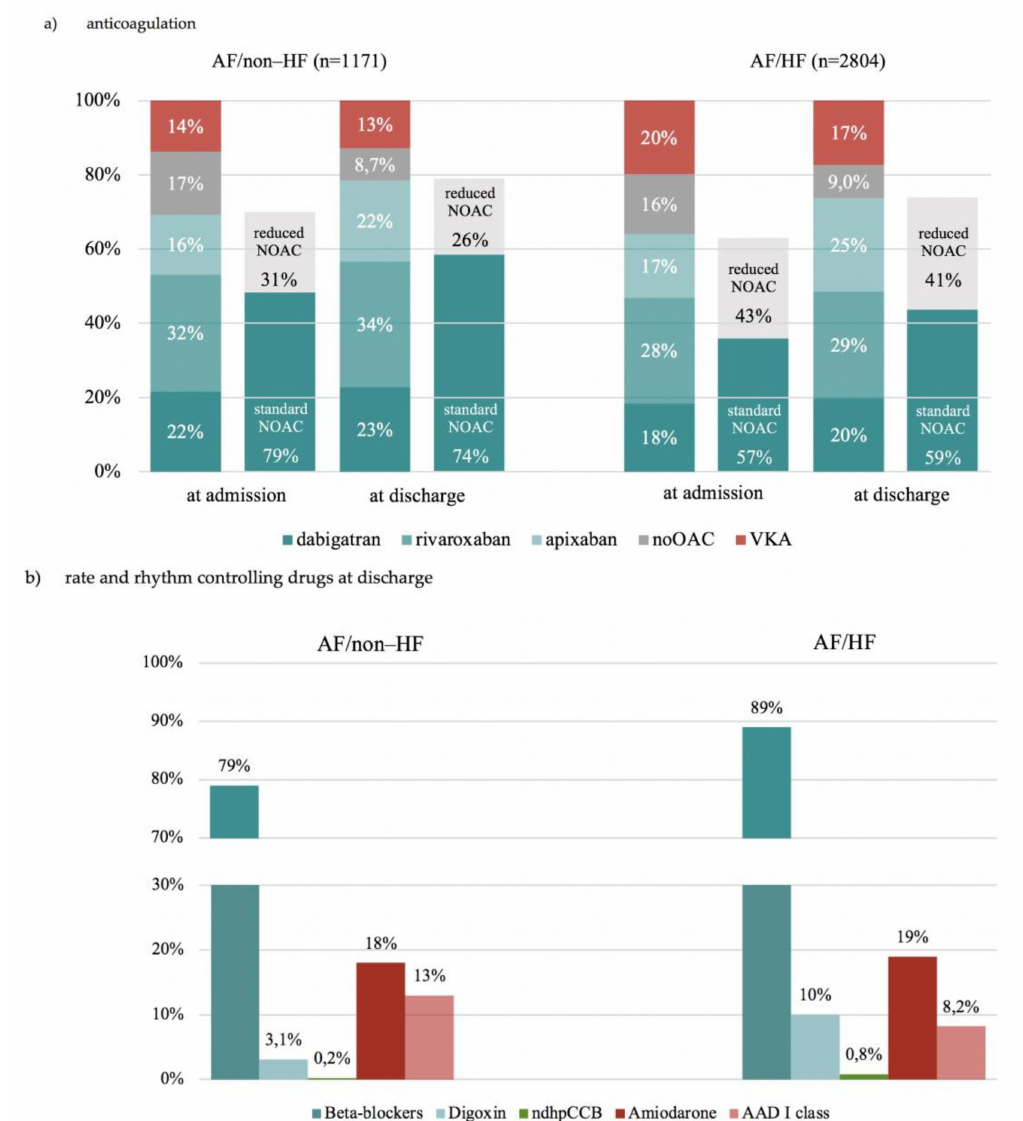
Figure 2. Pharmacotherapy of hospitalized atrial fibrillation patients depending on presence or absence of heart failure and its subtypes. ( a ) Differences between AF/non–HF vs. AF/HF group were statistically significant for all treatment subgroups ( p < 0.05), except no OAC at baseline ( p = 0.64), apixaban treatment at baseline ( p = 0.29), and no OAC ( p = 1.00) at discharge. Differences between AF/non–HF vs. AF/HF group regarding reduced and standard NOAC doses were statistically significant ( p < 0.05). ( b ) Dronedarone was not prescribed in any of the groups. Differences in pharmacotherapy between AF/nonHF vs. AF/HF group were statistically significant ( p < 0.05), except amiodarone treatment ( p = 0.53). Abbreviations: See Table 1; AAD, antiarrhythmic drug; ndhpCCB, non-dihydropyridine calcium channel blockers, NOAC, non-vitamin K antagonist oral